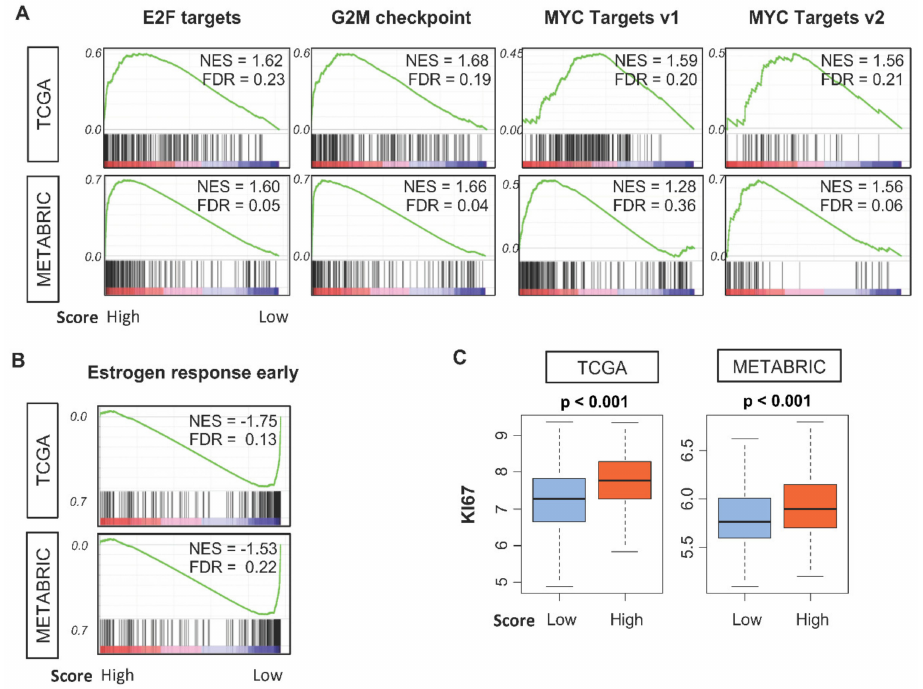
Figure 3. Gene expression enrichment in tumors of high or low 4-gene scores in TCGA ( n = 1093) and METABRIC ( n = 1903) cohorts. Enrichment plots along with normalized enrichment scores ( NES ) and false discovery rate (FDR) values are shown for the four and one gene sets whose expression was respectively enriched among high- ( A ) and low- ( B ) score tumors. (C) Tukey boxplots of tumor gene expression for KI67 gene (log 2 transcripts per million). Boxes depict medians and inter-quartile ranges. p values were calculated with one-way ANOVA test. Within-group one-third percentile value of the 4-gene score was used to divide patients into low and high